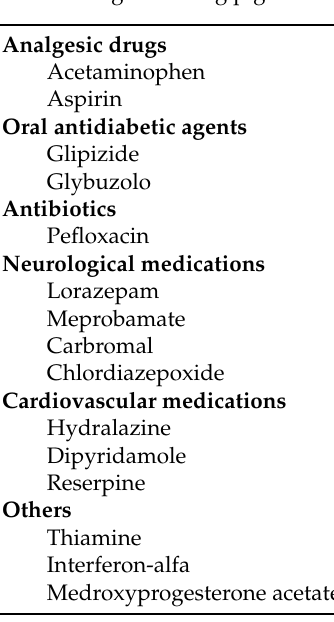
Table 1. Drugs inducing pigmented purpuric dermatoses.